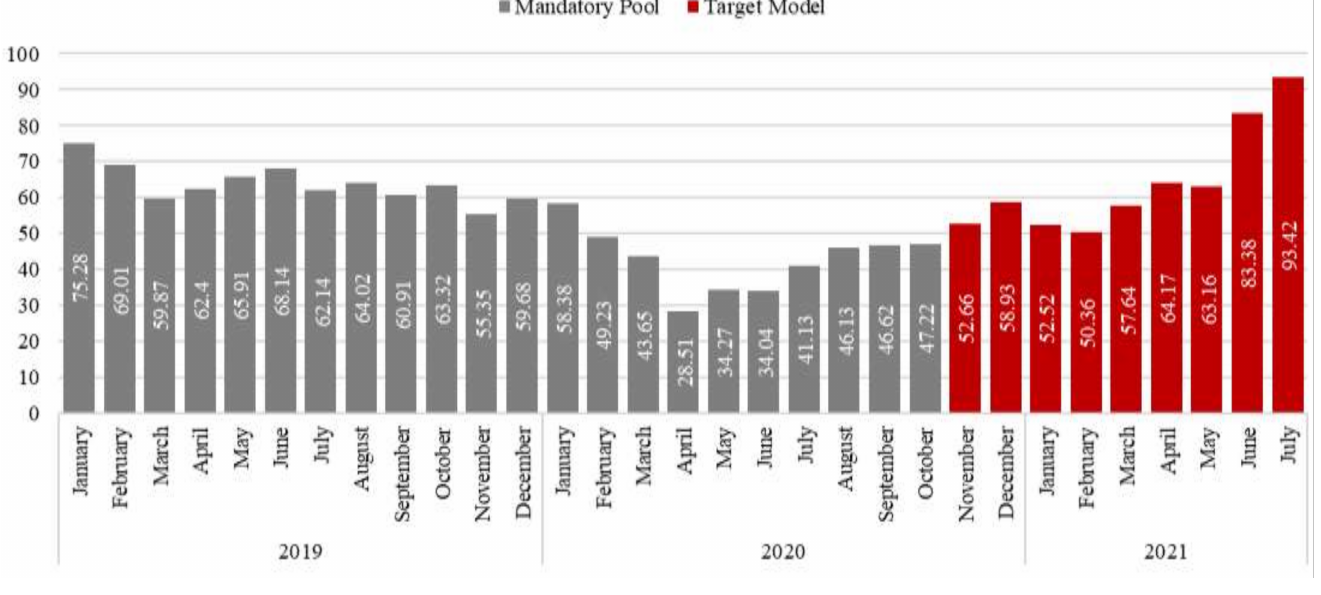
Figure 13. Monthly Average Market Clearing Price ( € /MWh), (2019–July 2021), Source: Hellenic Energy Exchange and Authors’ estimations.